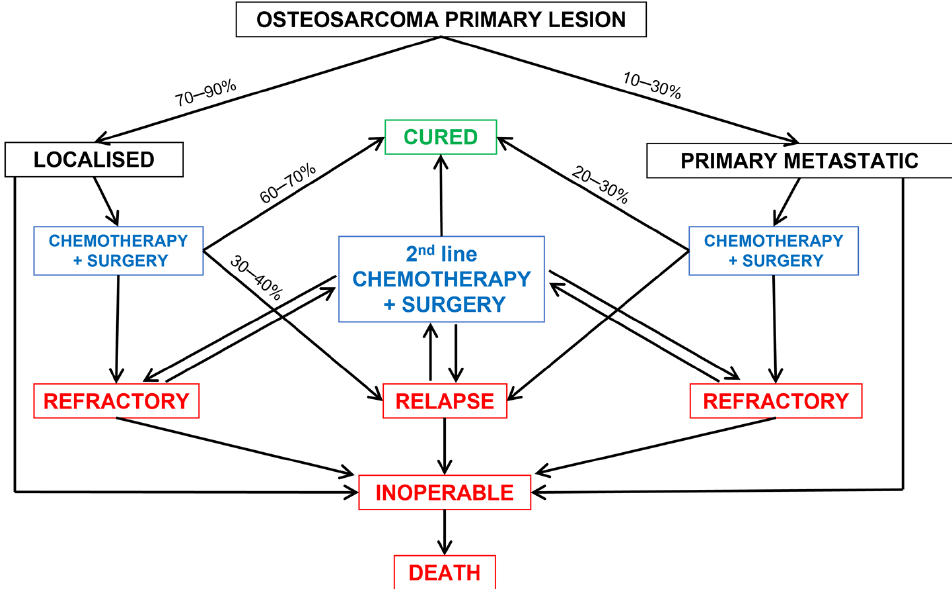
Figure 1. Metastatic evolution in osteosarcoma. The outcome depends on the occurrence of metastasis before diagnosis and/or relapse after treatment, the response to chemotherapy, and the possibility for full surgical resection. The text in black is for initial presentation, the text in blue is for therapeutic option, the text in red is for unfavorable evolution and the text in green is for favorable